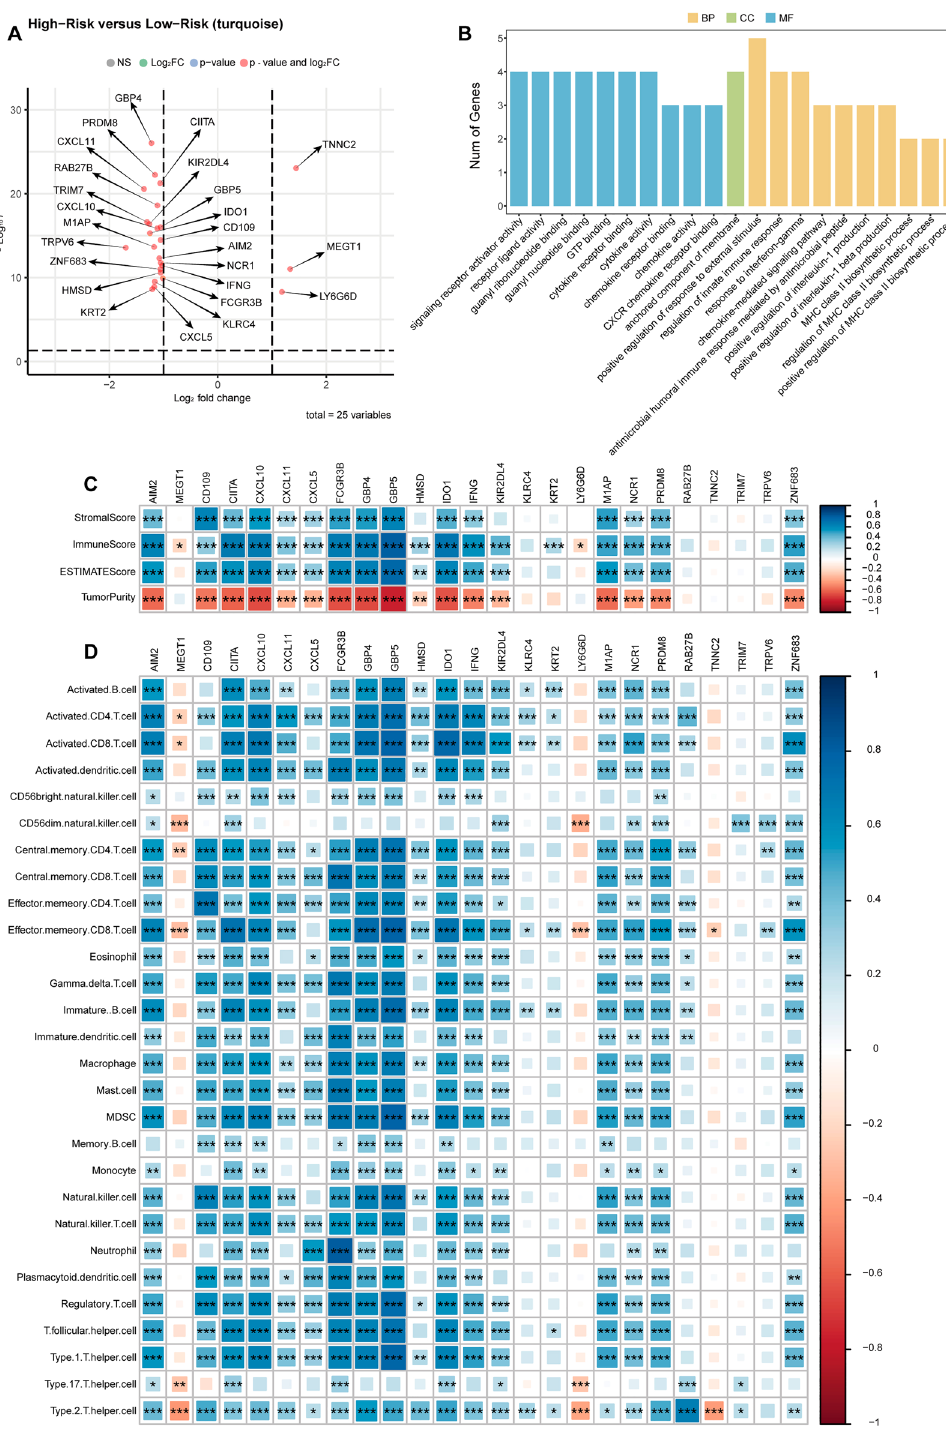
Figure 6. Analysis of hub gene immune-related characteristics. ( A ) Hub gene volcano plots. ( B ) Hub gene enrichment analyses. ( C ) The correlation heatmap between hub genes and industrial score, immune score, estimate score, and tumor purity is drawn by the corrplot function in the corrplot package of R language (version 4.1.2). ( D ) The heatmap of the correlation between the Hub gene and the immune cell expression of ssGSEA is drawn through the corrplot function of the corrplot package of R language (version 4.1.2). *P < 0.05; **P < 0.01; ***P <